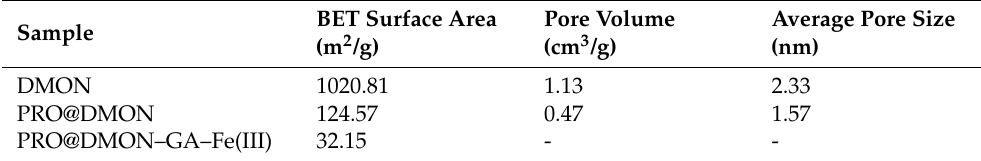
Table 1. Surface and porosity properties of the